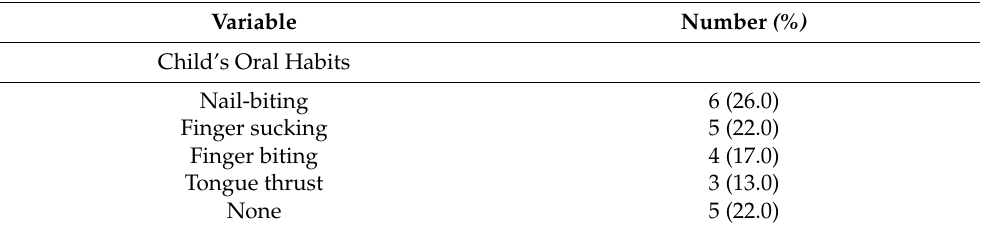
Table 1. Descriptive Statistics of Children’s Oral Habits ( n = 23).